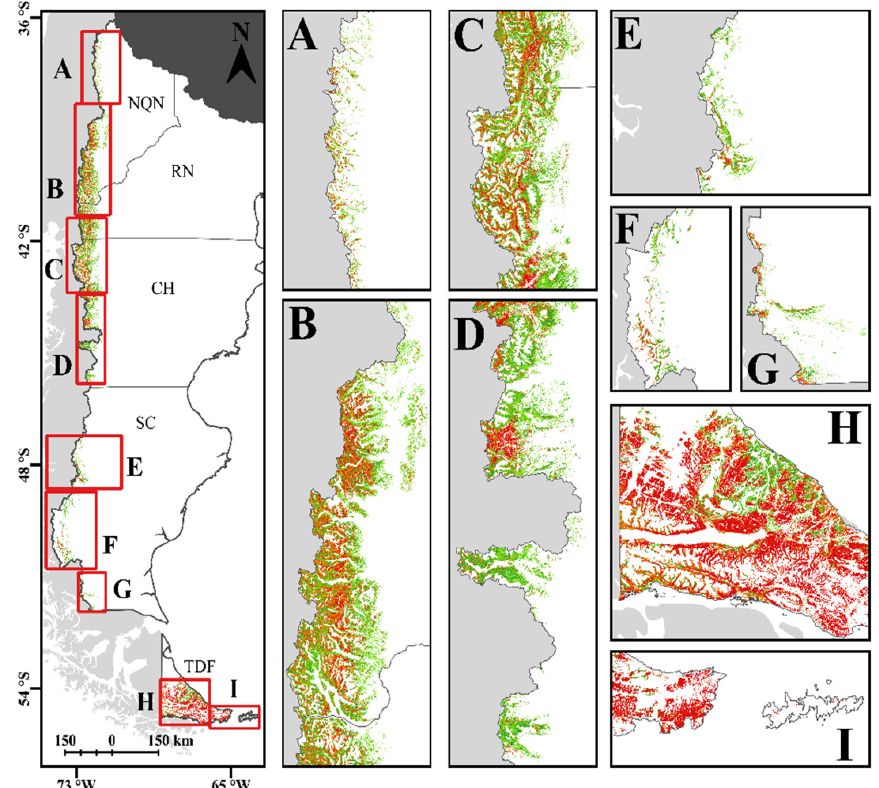
Figure 4. Model estimates of soil organic carbon content (SOC, ton C ha − 1 ) in the Patagonia region, where dark green represents the lowest (53.5 ton C ha − 1 ) values and red the highest (277.8 ton C ha − 1 ). ( A – I ) figures are zoom to forest sectors of the whole Patagonia region (left figure). Uncertainty, indicated by both relative RMSE (%) and absolute RMSE (ton C ha − 1 ), was well captured by our regression models (R 2 = 0.82 and 0.71, respectively) (Figure 5). In general, RMSE (%) decreased as SOC increased (reaching a maximum of 12%), while absolute RMSE (ton C ha − 1 ) increased as SOC increased (reaching a maximum of 15 ton C ha − 1 ) (Figures 6 and 7).